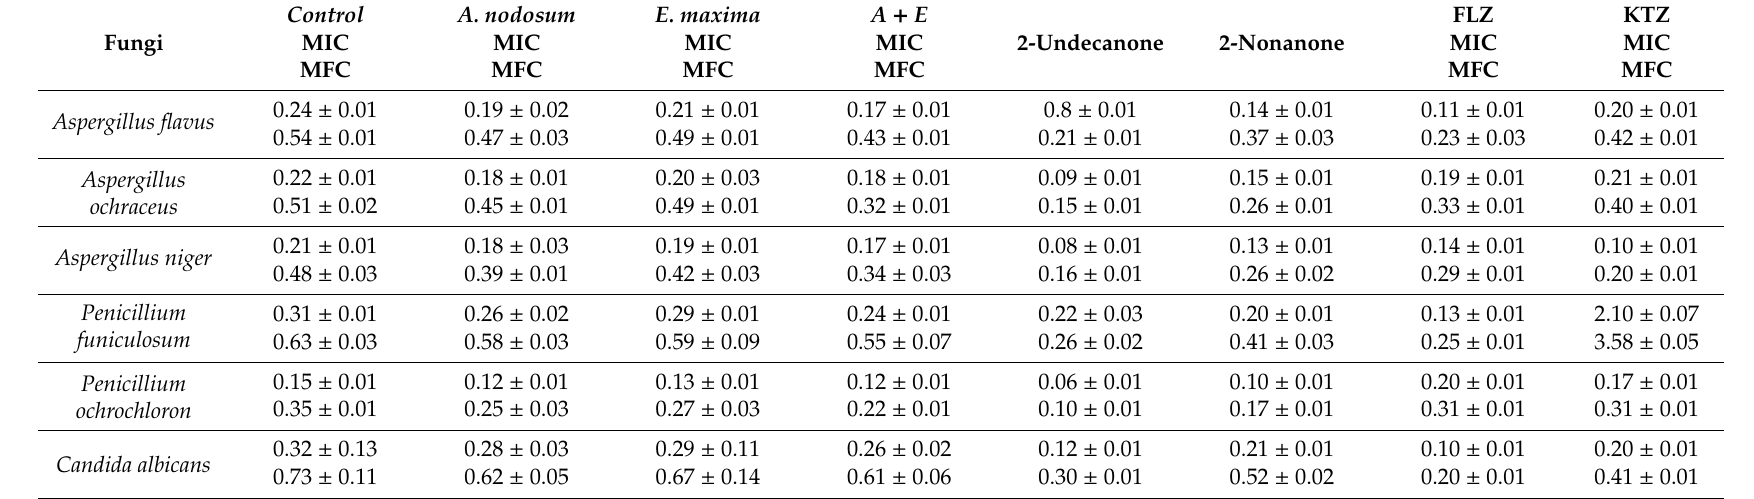
Table 4. Minimum inhibitory (MIC, mg mL − 1 ) and fungicidal concentration (MFC, mg mL − 1 ) of R. graveolens EOs as a ff ected by SWE